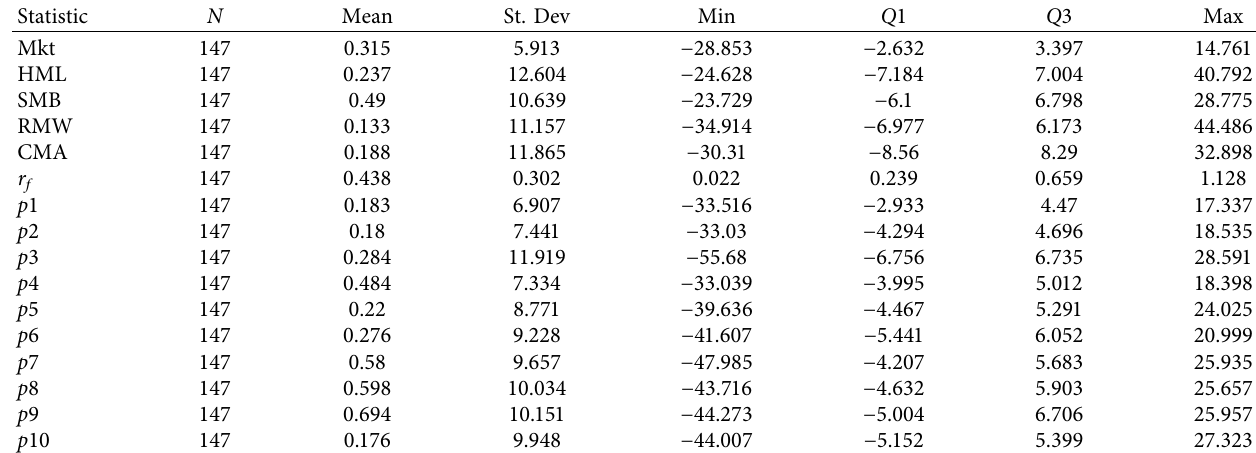
Table 2: Descriptive